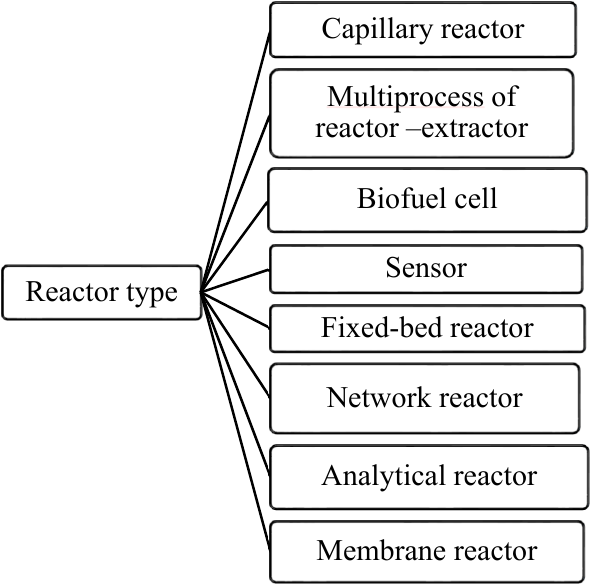
ff erent fields of